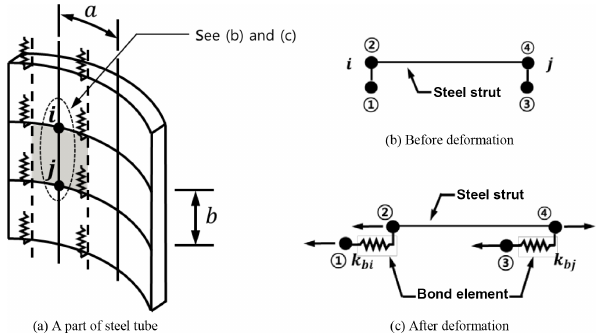
Figure 5. An idealized steel strut with bond-slip.